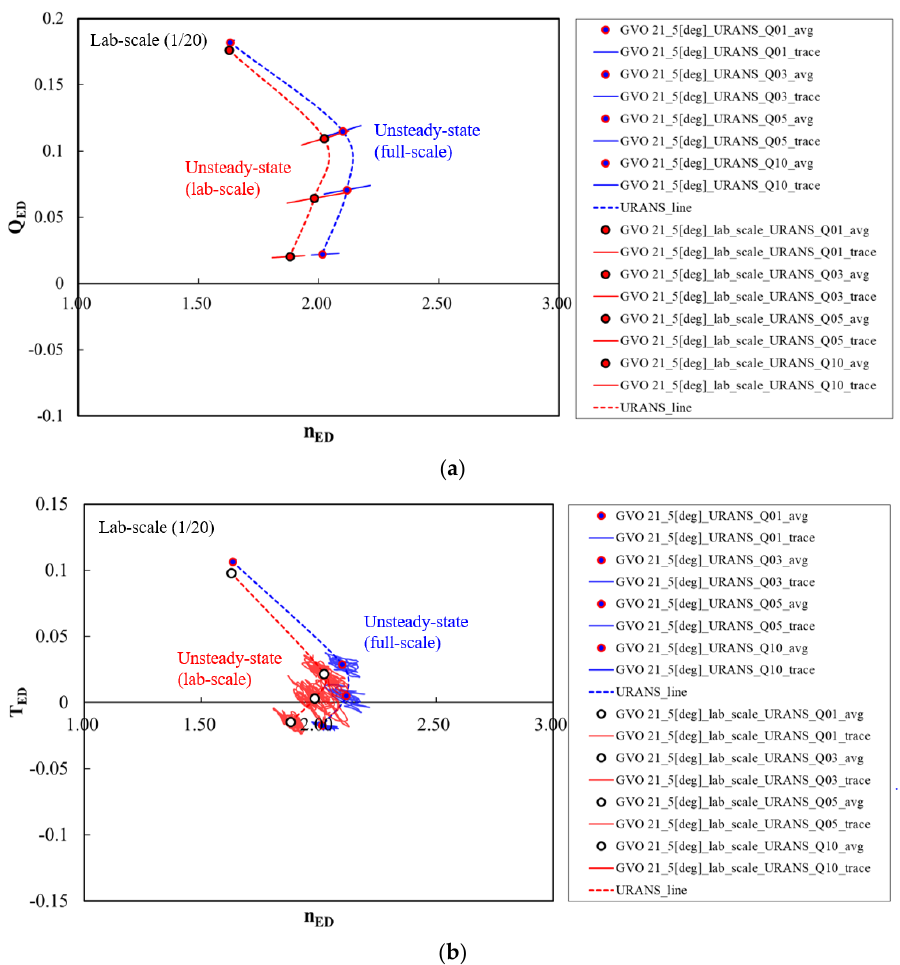
Figure 10. S-shaped characteristics of model scales at 21.5 ◦ GVO: ( a ) Speed factor vs. discharge factor; ( b ) speed factor vs. torque